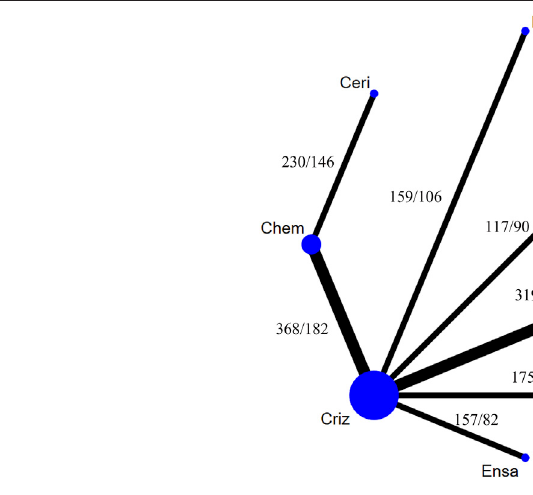
Frontiers in Pharmacology |